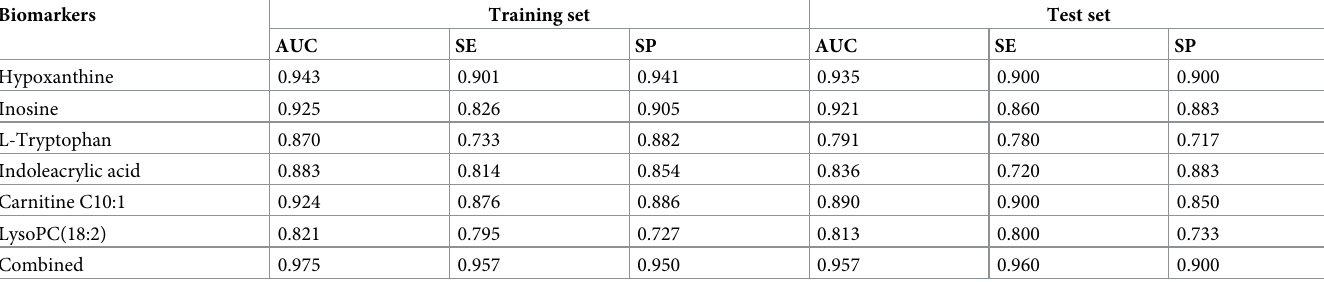
Table 2. AUC, SE, and SP of six biomarkers and the combination of these biomarkers for the training set and test set data. Biomarkers